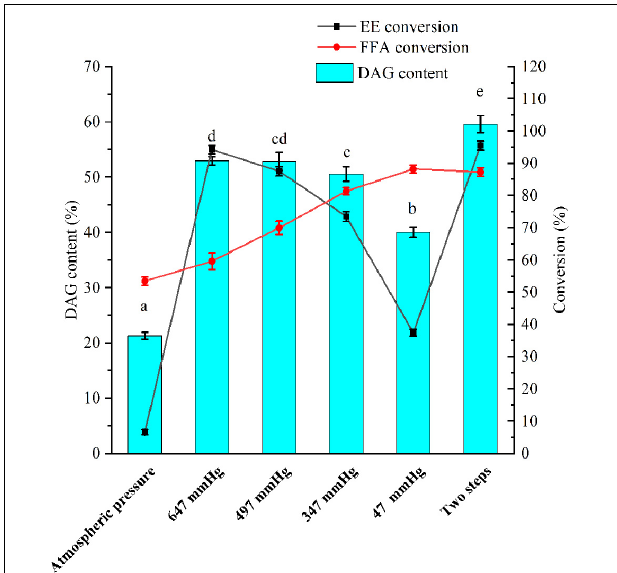
FIGURE 1 | A two-step vacuum-mediated conversion of fatty acid ethyl ester and fatty acid from soy sauce by-product oil (SSBO) to diacylglycerol (DAG)-enriched oil. Reaction condition: SSBO with high ethyl esther (EE) and free fatty acid (FFA): 50 g, ANL-MARE load: 3%, substrate molar ratio (glycerol/EE and FFA): 1:2, temperature: 55 ◦ C, different vacuum with air bubbling or two-step vacuum process, 150 rpm and reaction time: 8 h or 10 h. FFA: free fatty acid, EE: fatty acid ethyl esters, DAG: diacylglycerol. The different letters indicate significant differences at P <